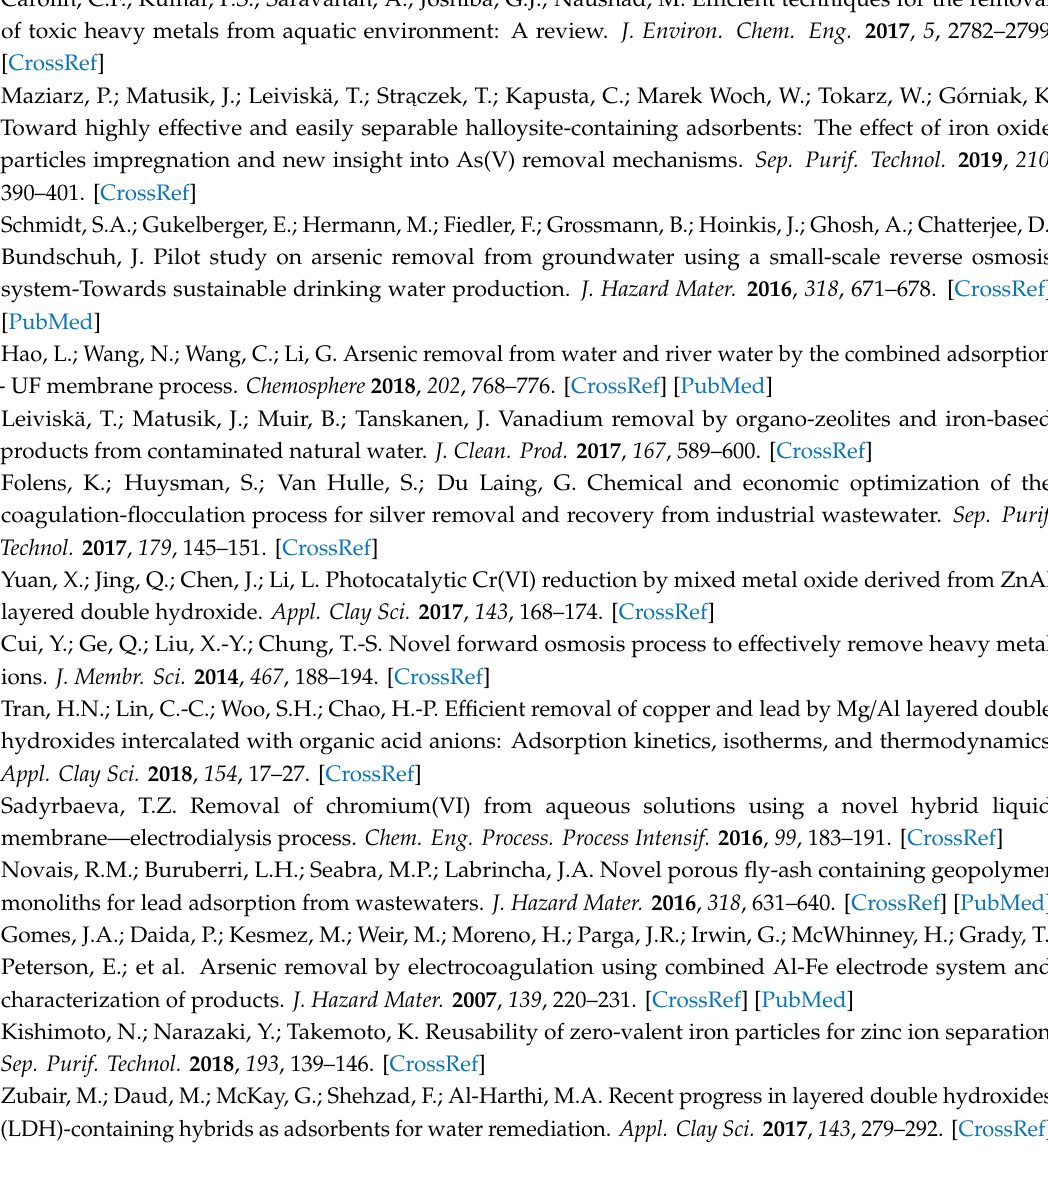
Figure S1: Thermal curves of the materials: ( a ) 5-H-LDH-M, ( b ) 5 H-LDH-P, ( c ) 15 H-LDH-M, ( d ) 15 H-LDH-P. Figure S2: Adsorption e ffi ciency after reaction of the adsorbents with ( a ) As(V) and ( b ) Cr(VI). Initial concentration (Cin) 5 mmol / L. Error bars may not be visible due to low discrepancy of results. Figure S3: Mg release and percent of dissolved LDH after reaction of the adsorbents: ( a ) As(V) and ( b ) Cr(VI). Initial concentration (Cin) 5 mmol / L. Error bars may not be visible due to low discrepancy of results. Figure S4. FTIR spectra of selected samples after reaction with